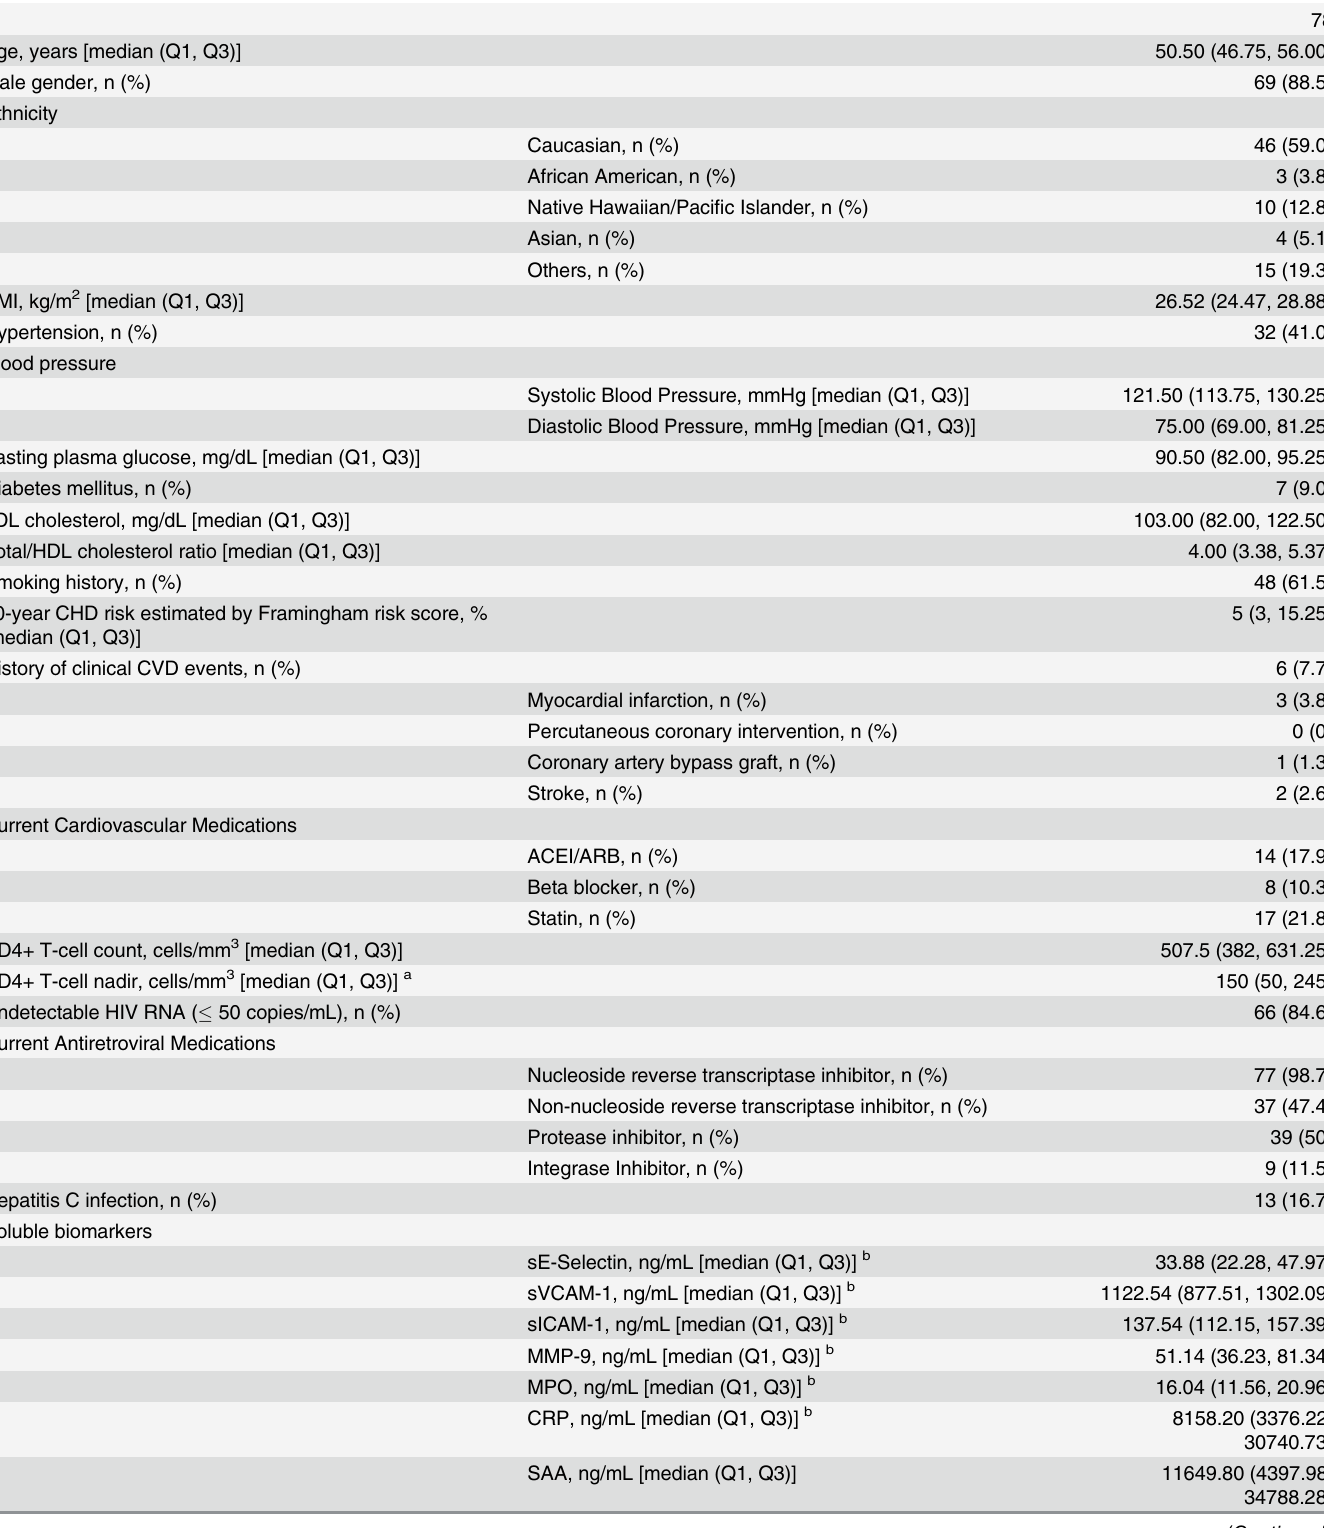
Table 1. Baseline characteristics, monocyte subset percentage, and soluble